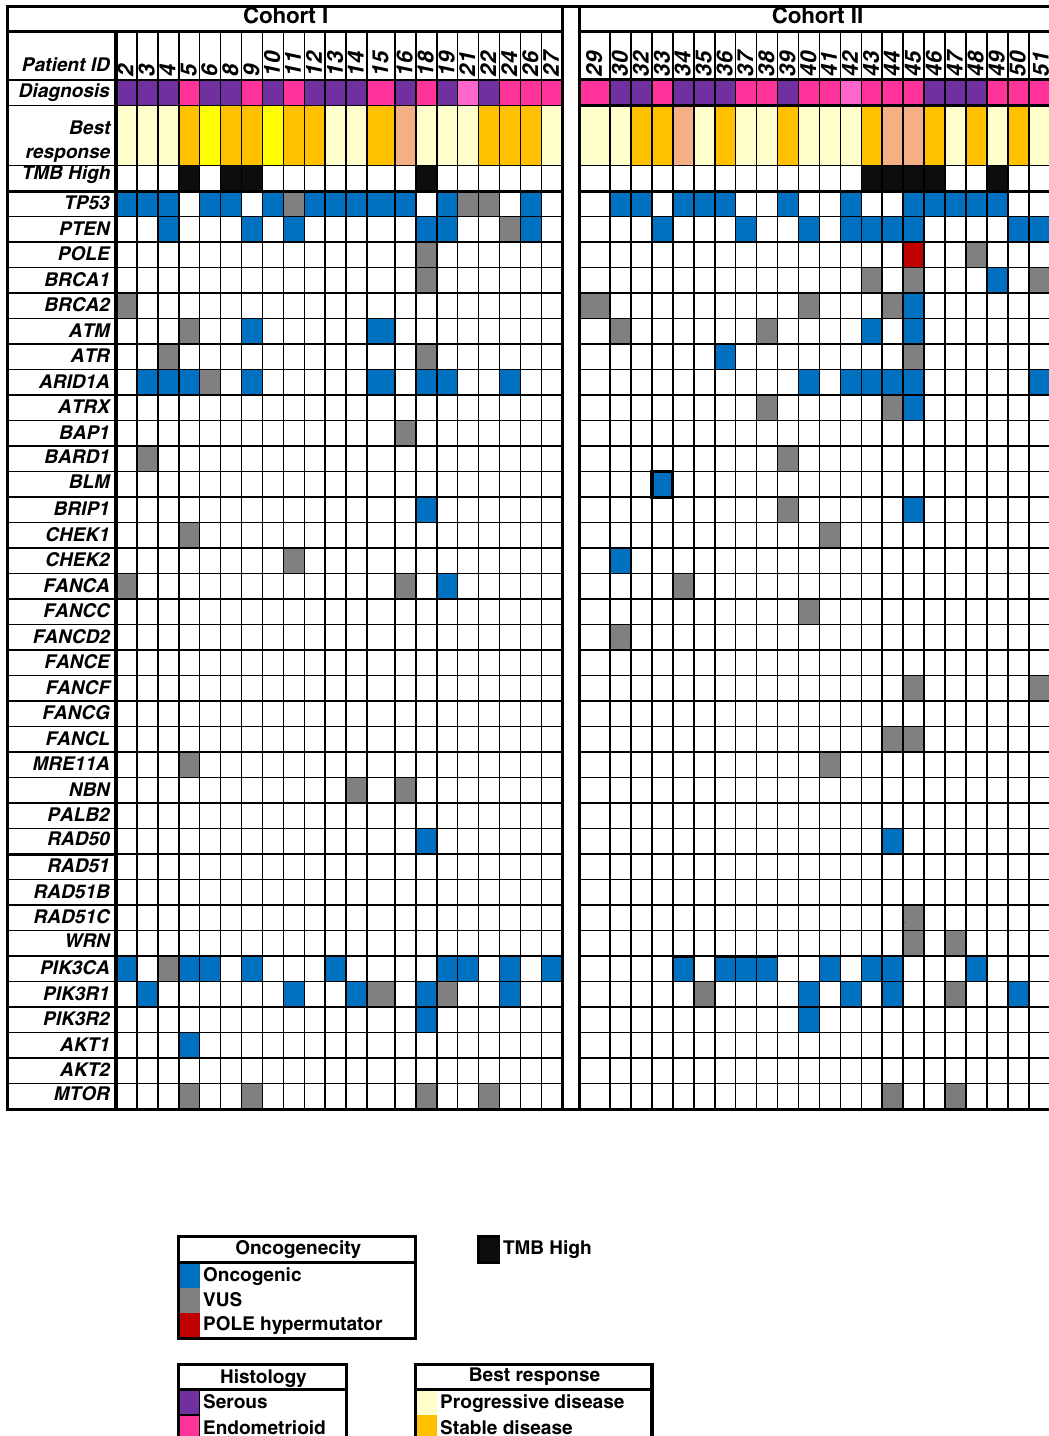
in the samples collected at response to therapy were the likely germline variants as observed at VAF close to 50% (Supplementary Table 3). No reversion BRCA1/2 variants were detected in ctDNA samples.